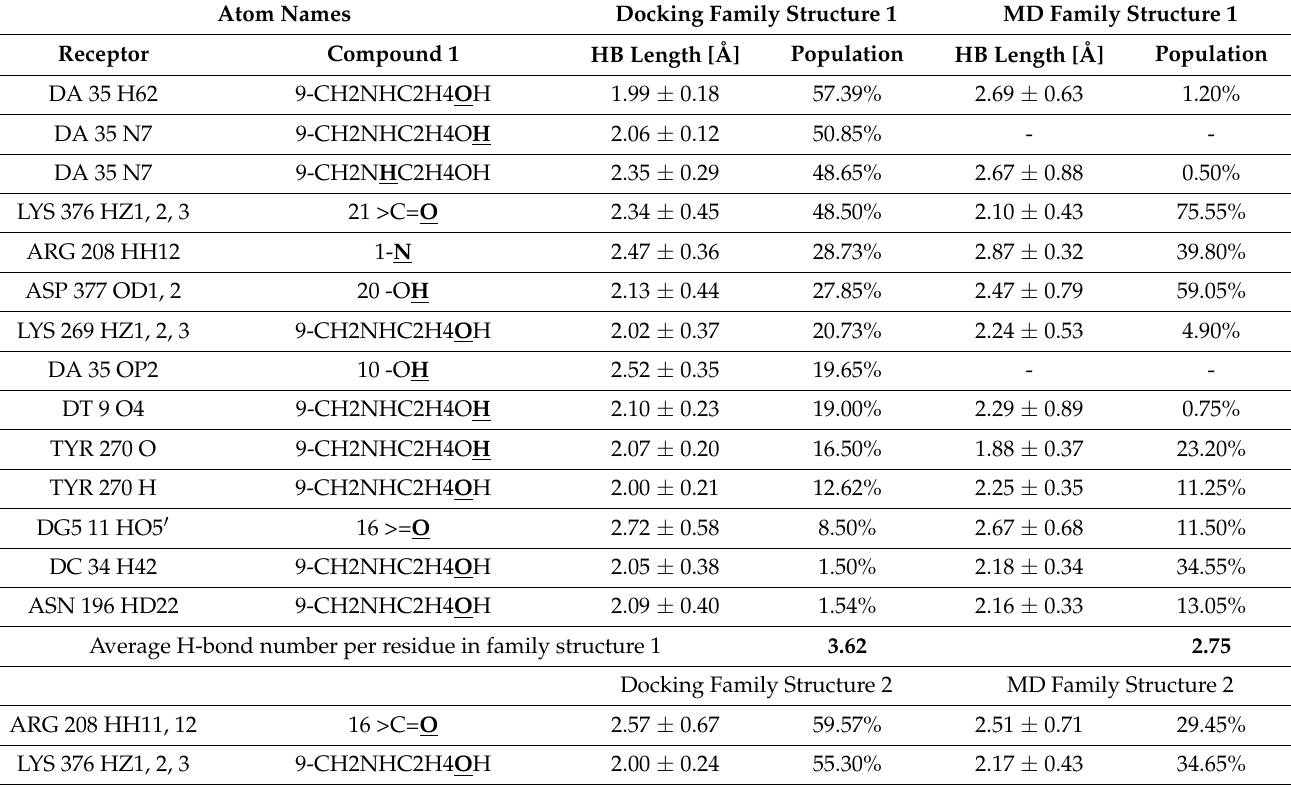
Table 4. Hydrogen bond (HB) statistic for compound 1 /DNA/Topo I ternary complex (only HB between compound 1 and DNA/Topo I receptor are